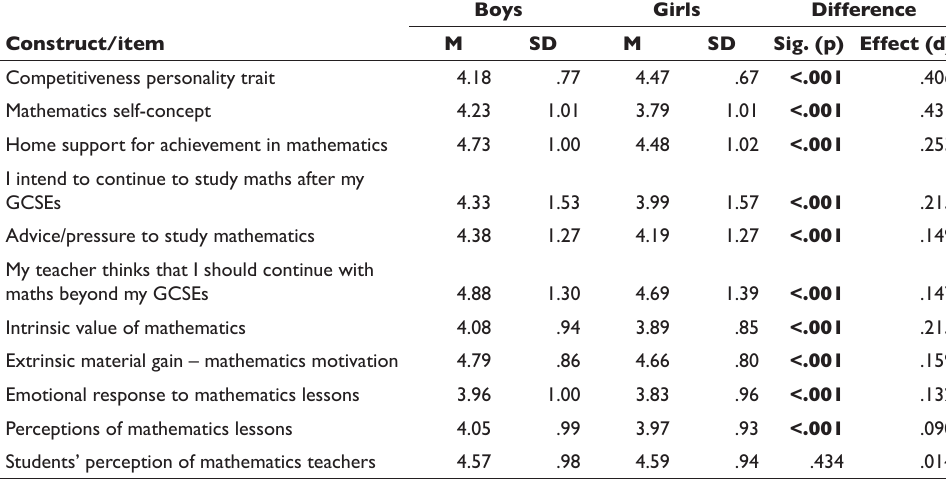
Table 1.1: UKyear8andyear10students:Surveyresponsesbystudentgender